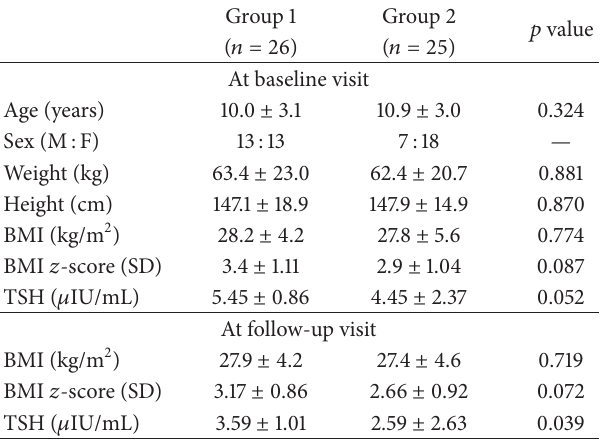
Table 1: Characteristics of groups.